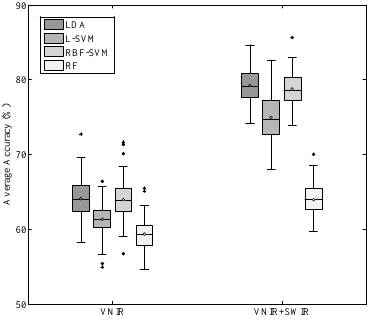
Figure 4. Variability of classification accuracy of the species using different methods with simulated WorldView-3 data based on hyperspectral